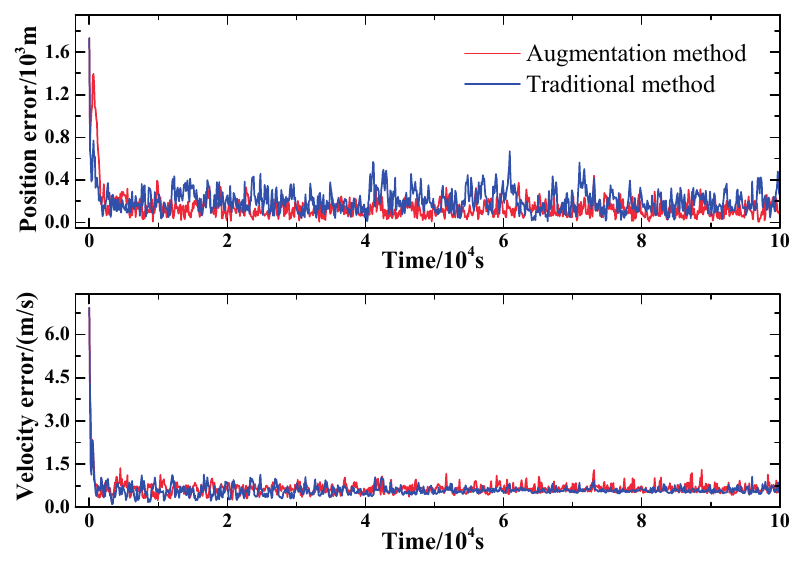
Figure 3. Position and velocity estimation error of the proposed method.